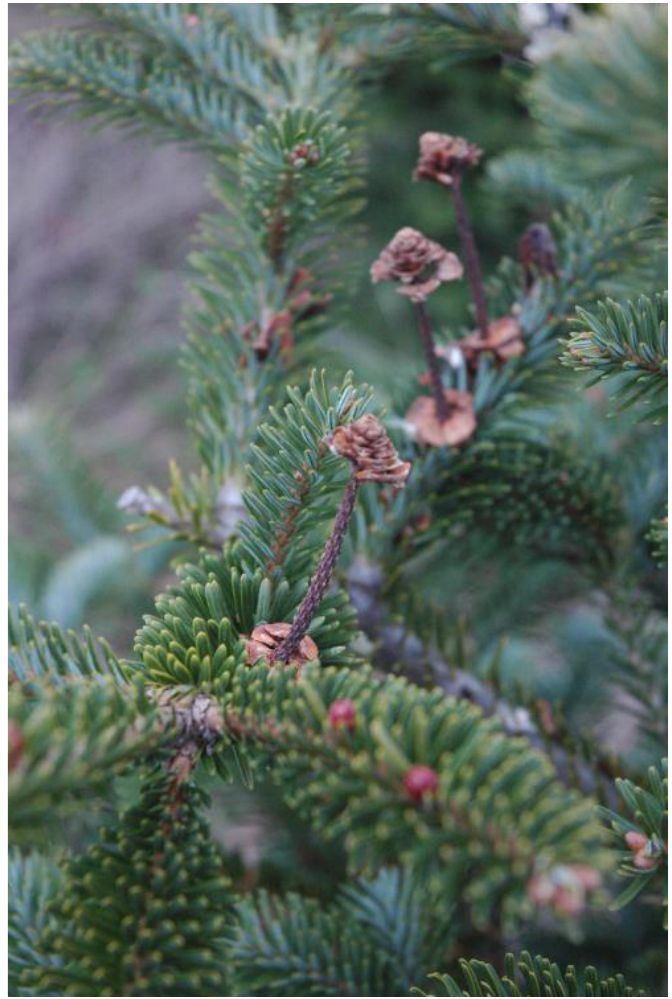
Figure 1. Fraser fir trees produce cones that disintegrate in the fall, leaving unsightly stalks on the tree.